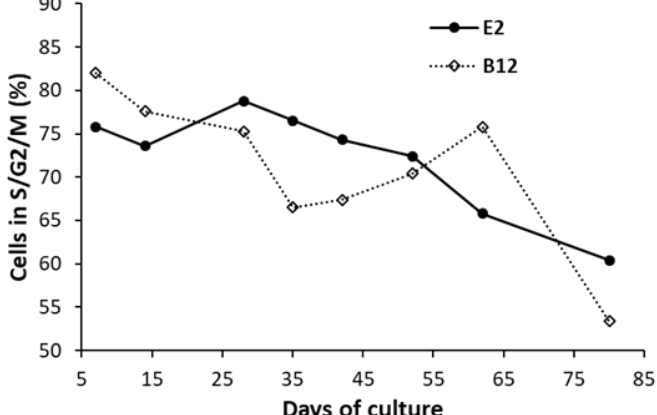
Figure 7. S / G2 / M cell percentage of E2 and B12 clones during serial culture passage. UT7 / Epo-FUCCI clone E2 and B12 were maintained in culture during 80 days after thawing with up to 25 culture passages. At indicated time points, cell cycle was evaluated by flow cytometry according to specific FUCCI protein expression. The graph represents the evolution of the percentage of cells in S / G2 / M cell cycle status during cell culture, as calculated in Fig S3A (E2) and B (B12) Results shown are the means of three independent measurements.